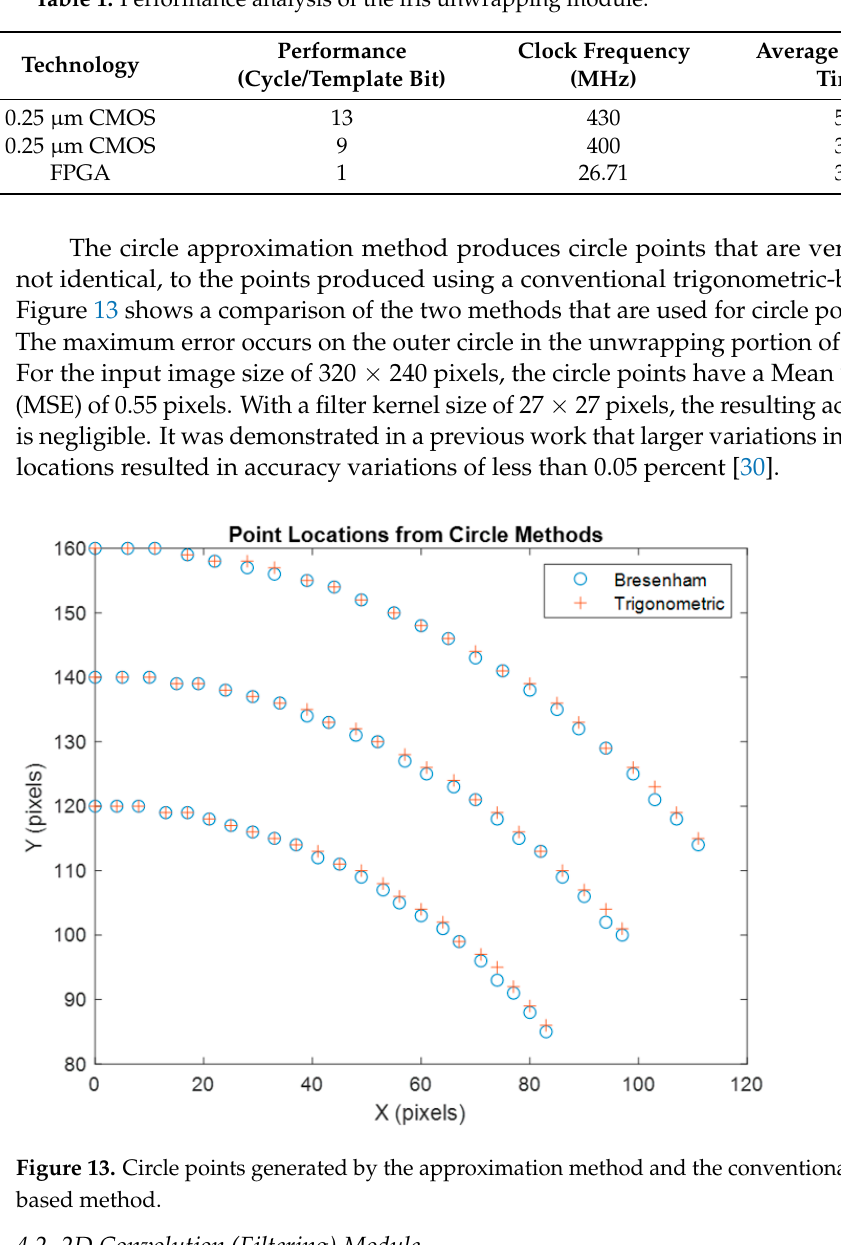
Table 1. Performance analysis of the iris unwrapping module.